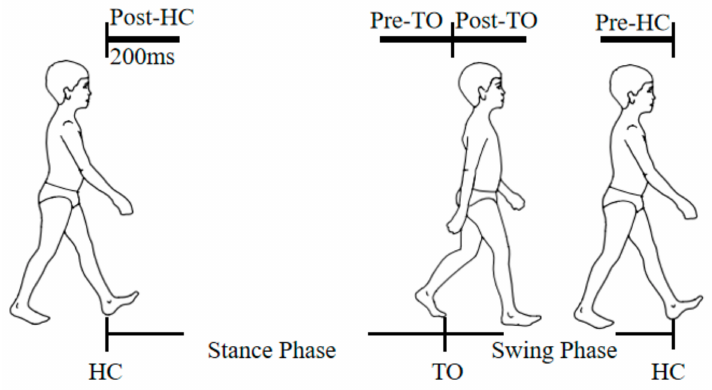
Figure 2. Four analysis windows aligned with heel contact (HC) and toe-off